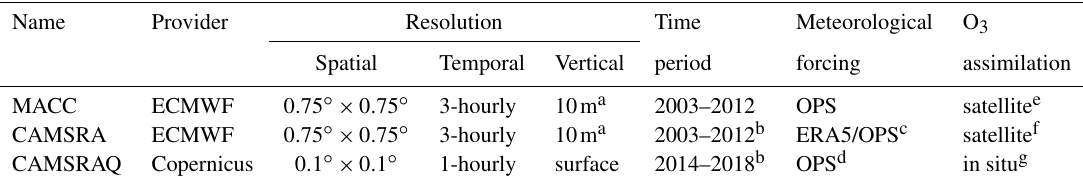
Table 2. Global/regional ozone reanalysis products used in this study.